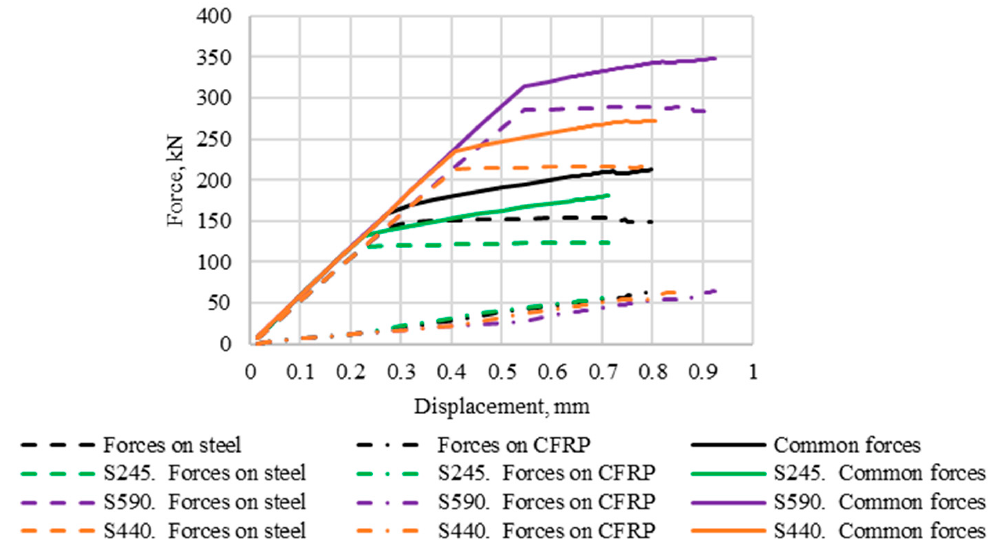
Figure 14. Displacement-force dependencies for strengthened specimens made of various steels.